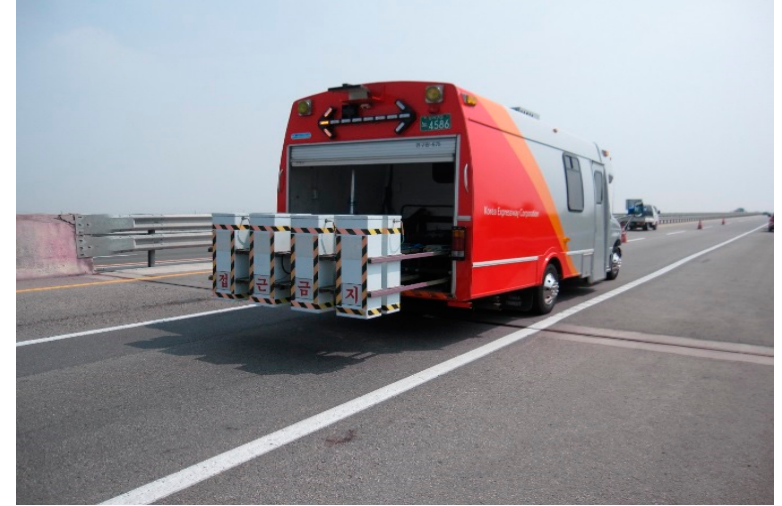
Figure 2. Photo of a GPR survey vehicle using 4-channel 1 GHz air-coupled antennas.